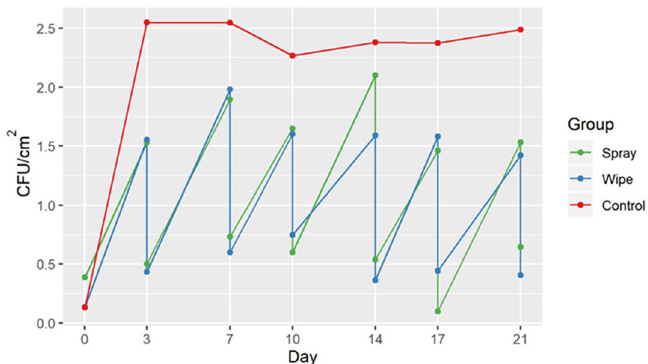
Figure 4. Pre/Post cleaning CFU/cm 2 .